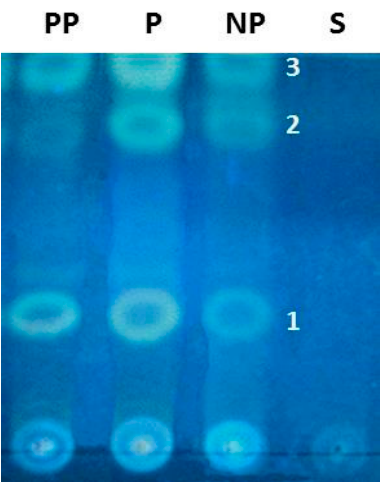
Figure 7. Chromatogram analysis revealed the presence of triterpenoids as marker chemical classes of post-partum ewes (PP), pregnant ewes (P) and non-pregnant (NP) samples, and a chemical profile that clearly portrait three major bands: 1, 2 and 3. These compounds were absent on S, the surrounding skin sample used as a negative control. The background color of the chromatogram is not uniform, which is a normal and recognized situation and does not interfere with the interpretation of the results.